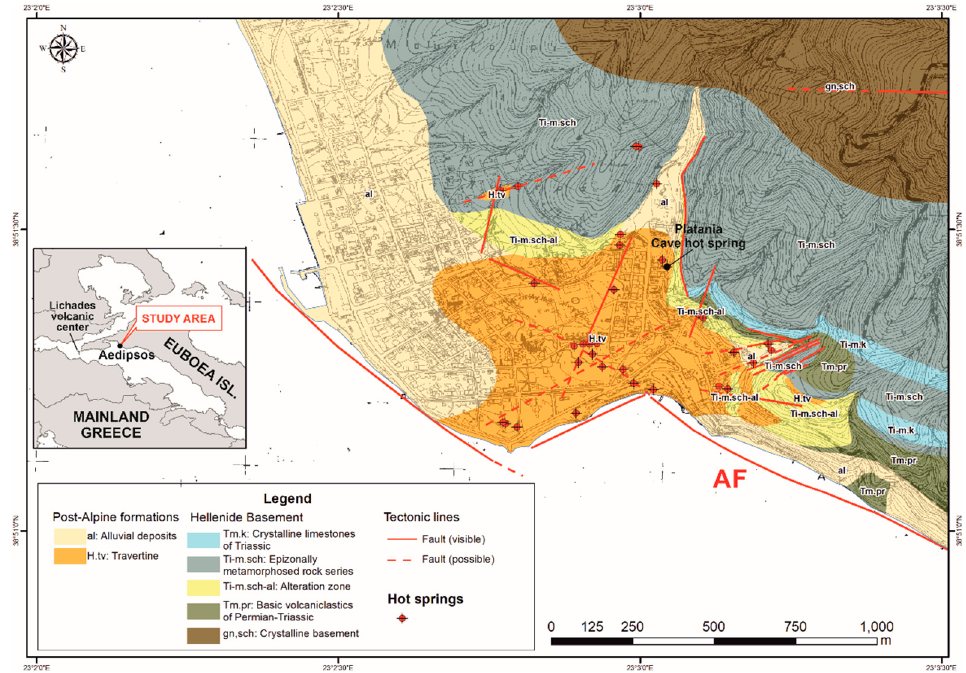
Figure 1. Geological map of the Aedipos area, NW of Euboea (AF = Aedipsos Fault; modified after Kanellopoulos et al. [25]). The sampling site is marked with a black dot. The geographical coordinates are in EGSA ‘87.